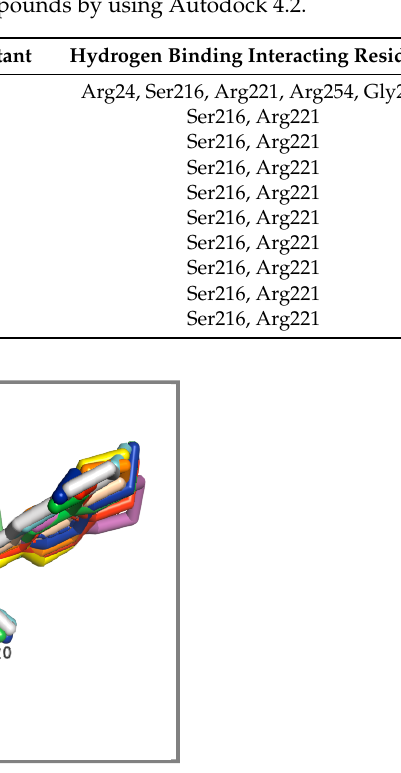
Figure 4. Molecular docking related PTP1B inhibition by 3,4-dimethoxy- β -nitrostyrene derivatives. Binding sites of compounds 1 , 2 , 3 , 4 , 5 , 6 , 7 , 8 , and 9 are represented by red, green, blue, yellow, magenta, cyan, orange, tint, and gray structures, respectively. The figure was generated using PyMol 2.0.